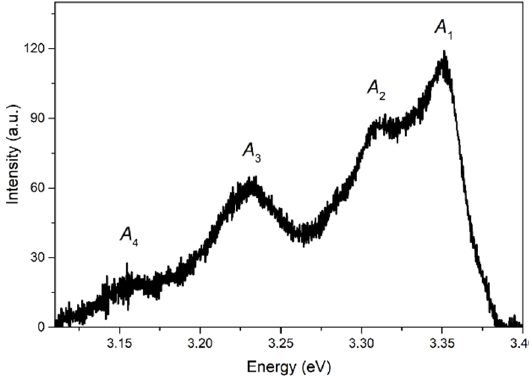
Figure 6. NBE emission spectrum of the sample at T ~ 80 K.